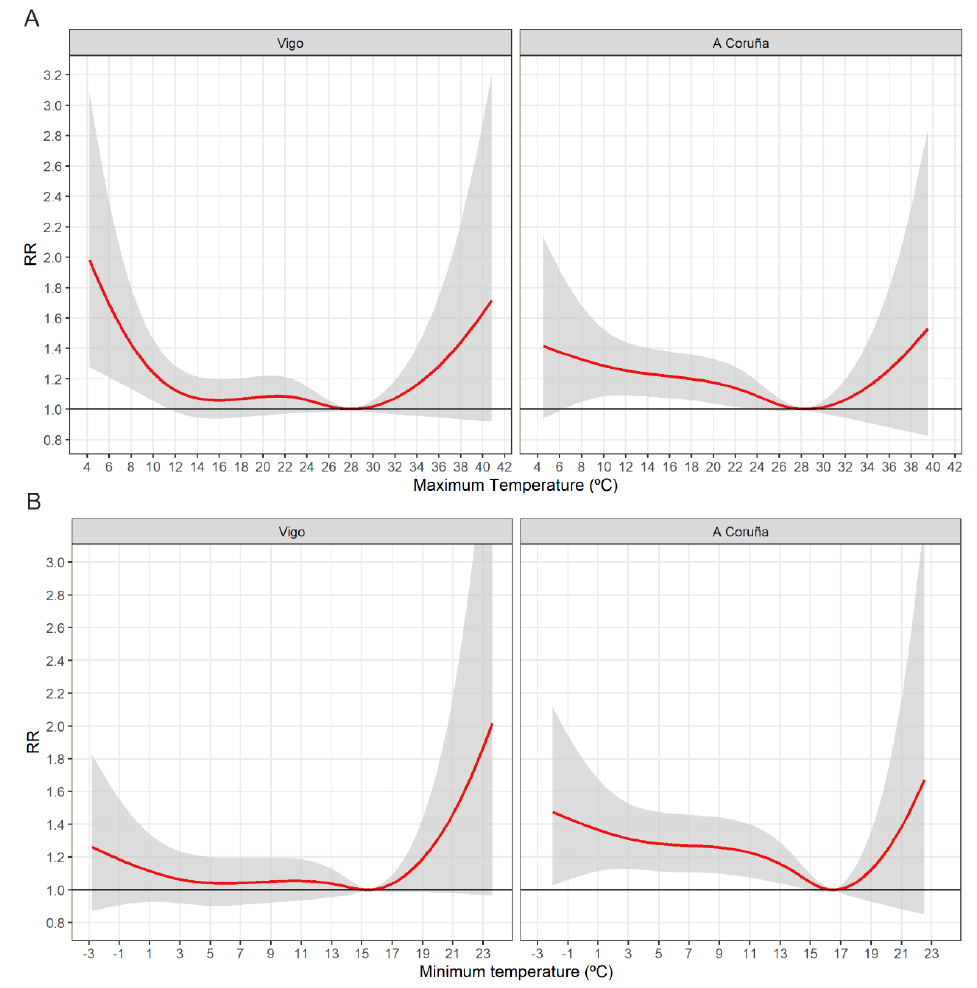
Figure 1. Overall cumulative exposure-response associations between maximum ( A ) and minimum temperature ( B ), and emergency medical calls in the cities of Vigo and A Coruña. The distribution according to sex in the two cities displayed the same pattern, with 59% of emergency call patients being women and only 40.8% men; 76.2% of all patients were over 64 years of age. The most frequently diagnosed diseases were stroke, cardiac failure, and chest pain of an ischaemic nature.